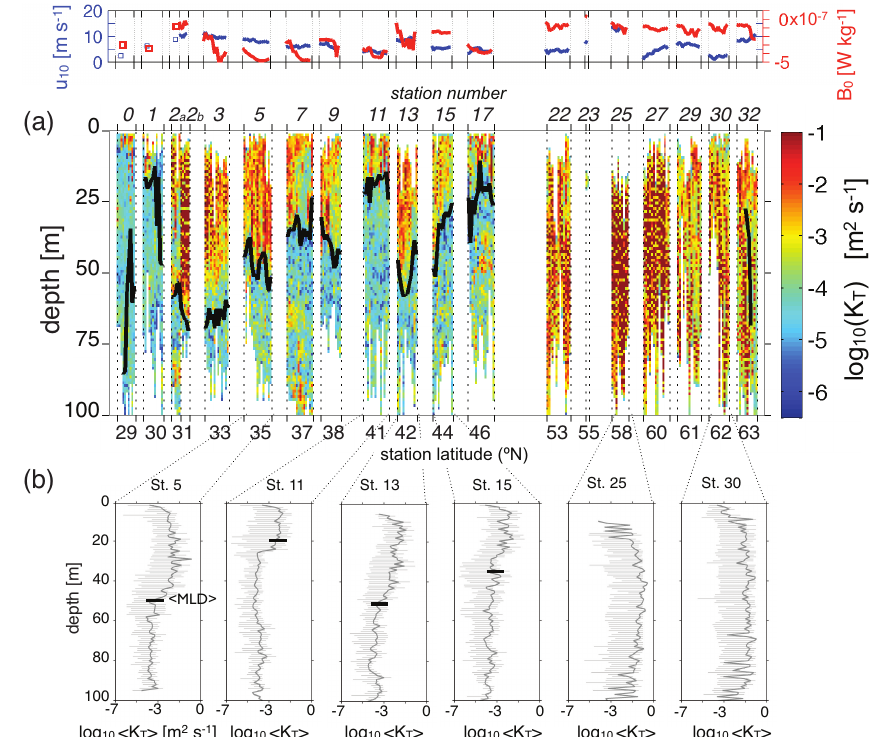
Fig. 5. Depth-binned profiles of temperature eddy diffusivity K T (a) , and station-averaged profiles at representative stations (b) . The ranges of minimum and maximum values around the station-average are shown in (b) . The wind speed at 10m height u 10 and the net surface buoyancy flux B 0 are depicted in the top panel. Station numbers are labelled on the top axis, and the corresponding latitude is shown on the bottom axis. The mixed layer depth (MLD) for each cast is also plotted as the thick black curve. The angle brackets indicate a station-average.